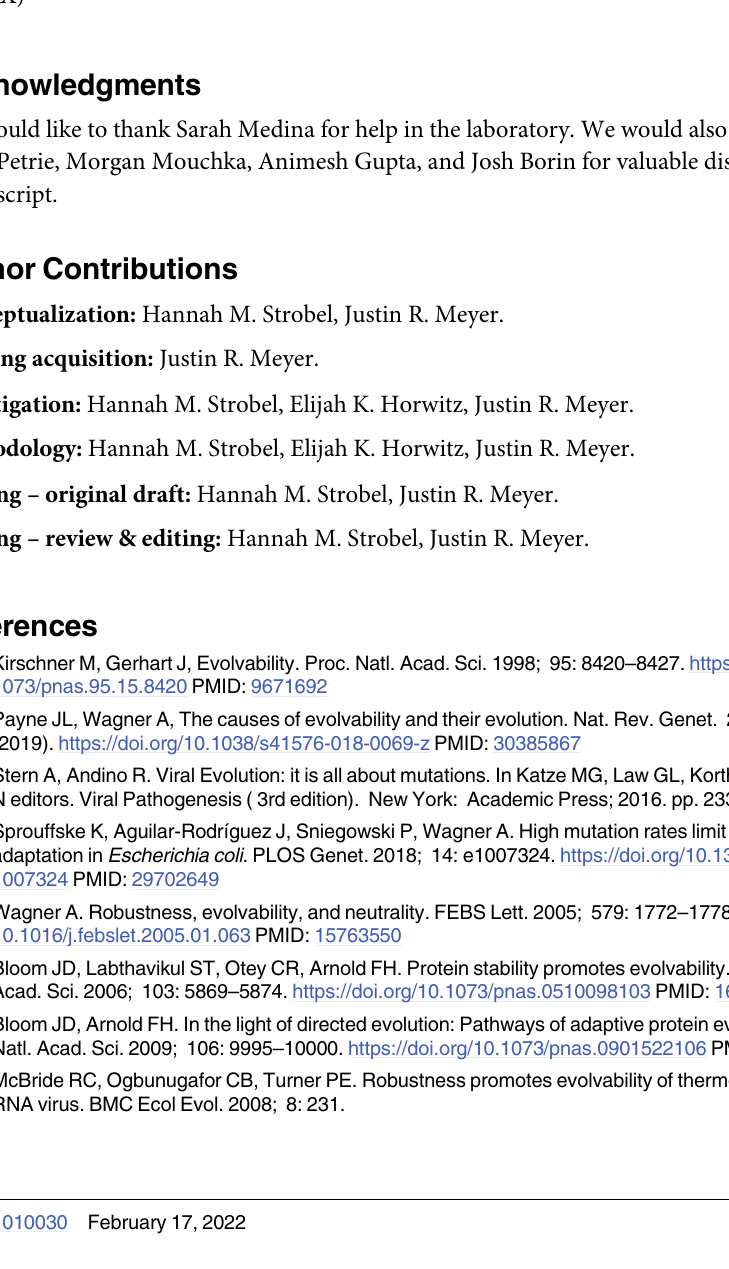
S3 Table. Unadjusted and adjusted decay rates for engineered library variants. S4 Table. λ growth rates on lamB − hosts measured in liquid culture on D6 of the replay experiment. Positive growth rates are bold. Growth rates could not be calculated (“NA”) for some populations (6-mut T987A 2 and 6-mut F1122L 1 and 2) because no viable phage were detected at day 6 (i.e. the population had gone extinct), or because phage decayed to zero dur- ing the overnight growth period on lamB — (6-mut T987S 4). Growth rates for each population were measured in a single replicate. S1 Text. Text on two additional experiments. First, a description of a high throughput genetic engineering method and assay for evaluating whether lambda strains are one mutation (N1107K) away from gaining the use of OmpF. Second, a description of a more sensitive assay for detecting OmpF use than plate-based spot